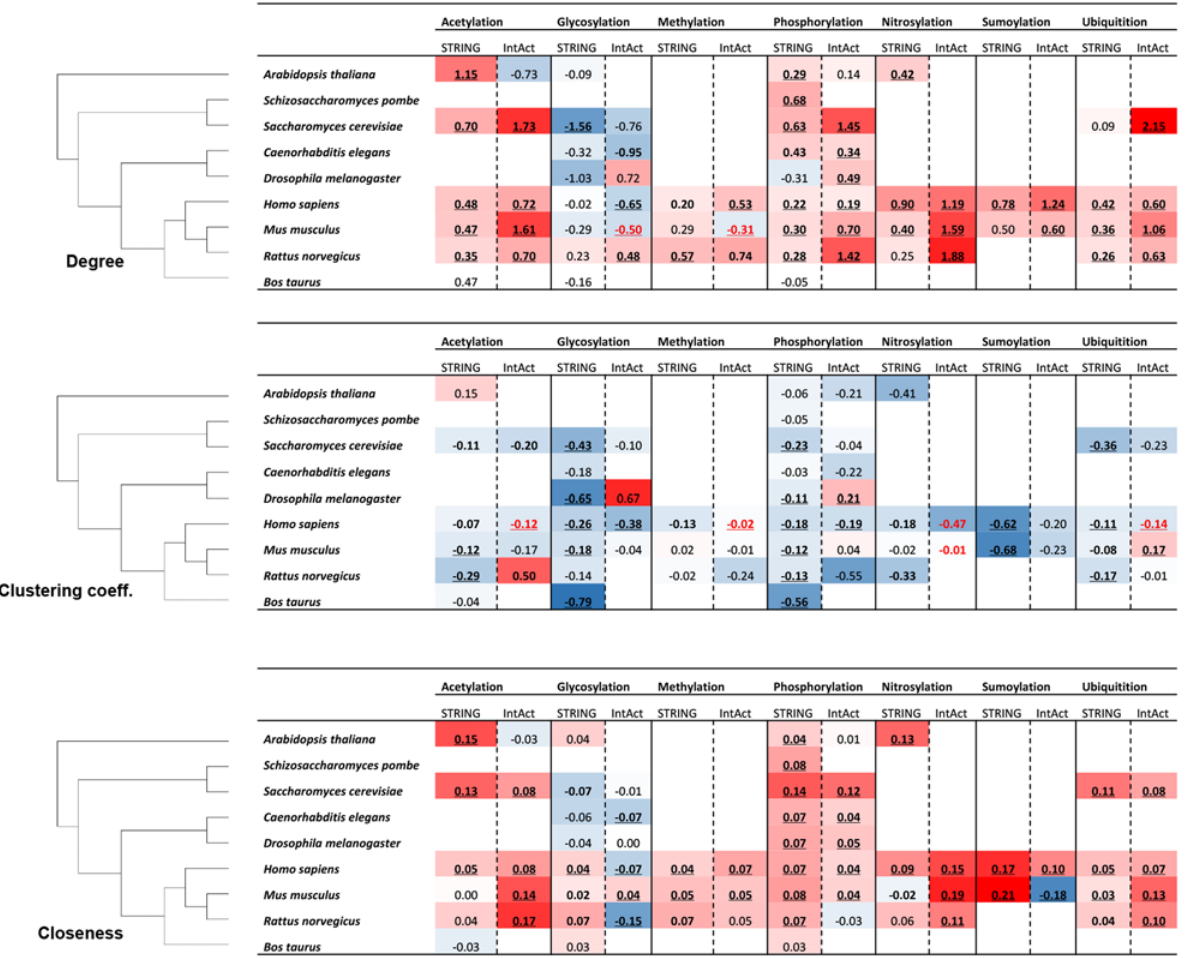
Figure 5. Degree, clustering coefficient, closeness centrality analysis for proteins with different PTM-types in each considered species and associated high-confidence STRING and IntAct PIN. The species are ordered according to their phylogenetic relationships as shown on the left. For every PTM-type, the log-2 of fold difference value for the degree/clustering coefficient/closeness centrality value relative to the respective value associated with proteins not carrying this particular PTM-type are given for PINs based on STRING and IntAct, respectively. Color scale indicates increased (red) or decreased (blue) values in the PTM-set relative to the non-PTM-set with symmetric color intervals (i.e. full color saturation based on the maximal absolute increase or decrease fold difference observed across all values in the table.) Bold-font (underlined) fold-changes indicate significant fold-changes at p < 0.05 ( p < 0.01) by Mann-Whitney test with FDR correction, the values in red or blue text represent significantly higher or lower network properties, which are inconsistent with the background color based on mean (not median) values. PTM-types “ carboxylation ” , “ proteolytic cleavage ” , “ hydroxylation ” , and “ disulfide bond ” are not included in this analysis as associated numbers were available for Homo sapiens